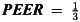
Comparison of the reconstructed profiles versus the ground truth along the central horizontal line when PEER = 13 without data noise.The blue solid lines are the profiles through the reconstructed images. The purple dash-dot ones are the initial estimation. The red solid ones are the ground truth. The yellow dash ones indicate the FOV defined by the PCDs. From (a) to (h) are the results in the 1st to 8th energy channels respectively.